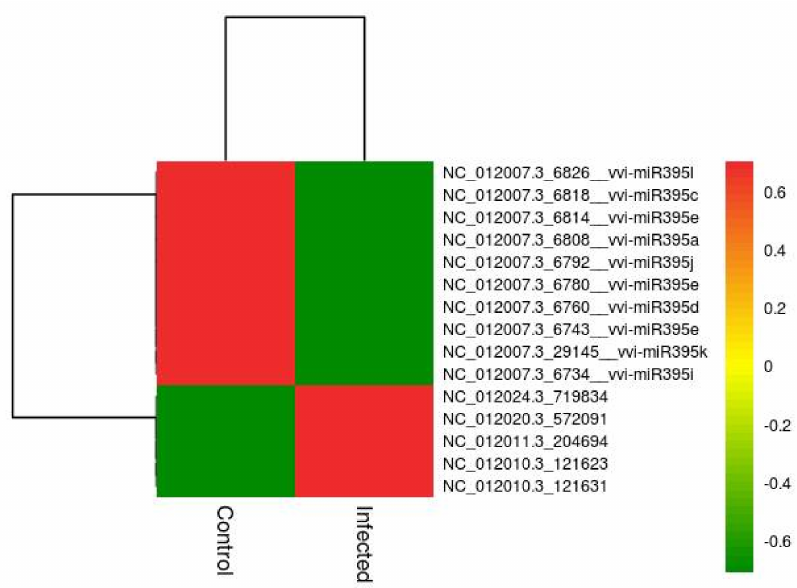
Figure 3. Heatmap of expression profile (Log 2 -based values) (upregulation vs. downregulation) of the differential expressed miRNAs in SDW-control vs. pathogen-infected samples. The heatmap was generated using the Rstudio program (A package of R,